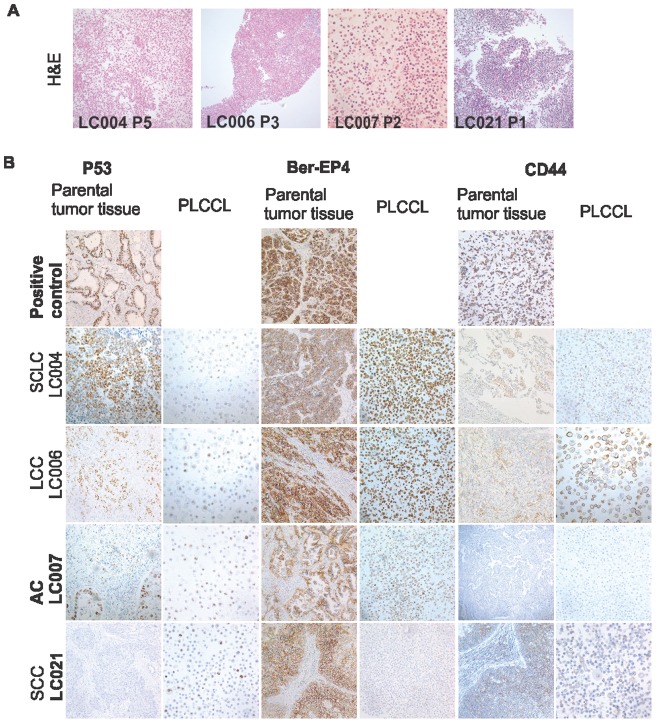
Comparison of morphological and phenotypic features between the PLCCLs and corresponding tumor tissues.
A. H&E staining of the 4 representative primary lung cancer cell lines for different lung cancer subtypes: the SCLC cell line LC004; the LCC cell line LC006; the AC cell line LC007 and the SCC cell line LC021. The cells derived from the four subtypes of lung cancer showed heterogeneity in cellular and nuclear morphology. Cells of each primary cell line had epithelial morphology. Photomicrograph magnification, ×200. B. Analysis the expression of P53, Ber-EP4 and CD44 in the 4 primary cell lines and their corresponding archival patients' tumor tissues. All the primary cell lines investigated showed diffuse positive staining for P53 except the original SCC tissue of cell line LC021. Epithelial membrane antigen Ber-EP4 was widely positive in all the original lung cancer tissues and diffuse positive in all the primary cell lines. CD44 showed diffuse positive staining with different intensity in the primary cell lines and their corresponding archival patients' cancer tissues except weakly positive in the original tumor tissue of the AC cell line LC007. Sections from paraffin blocks containing human seminoma and breast cancer specimen were used as positive controls for antibodies P53, Ber-EP4 and CD44, respectively. Photomicrograph magnification, ×200.